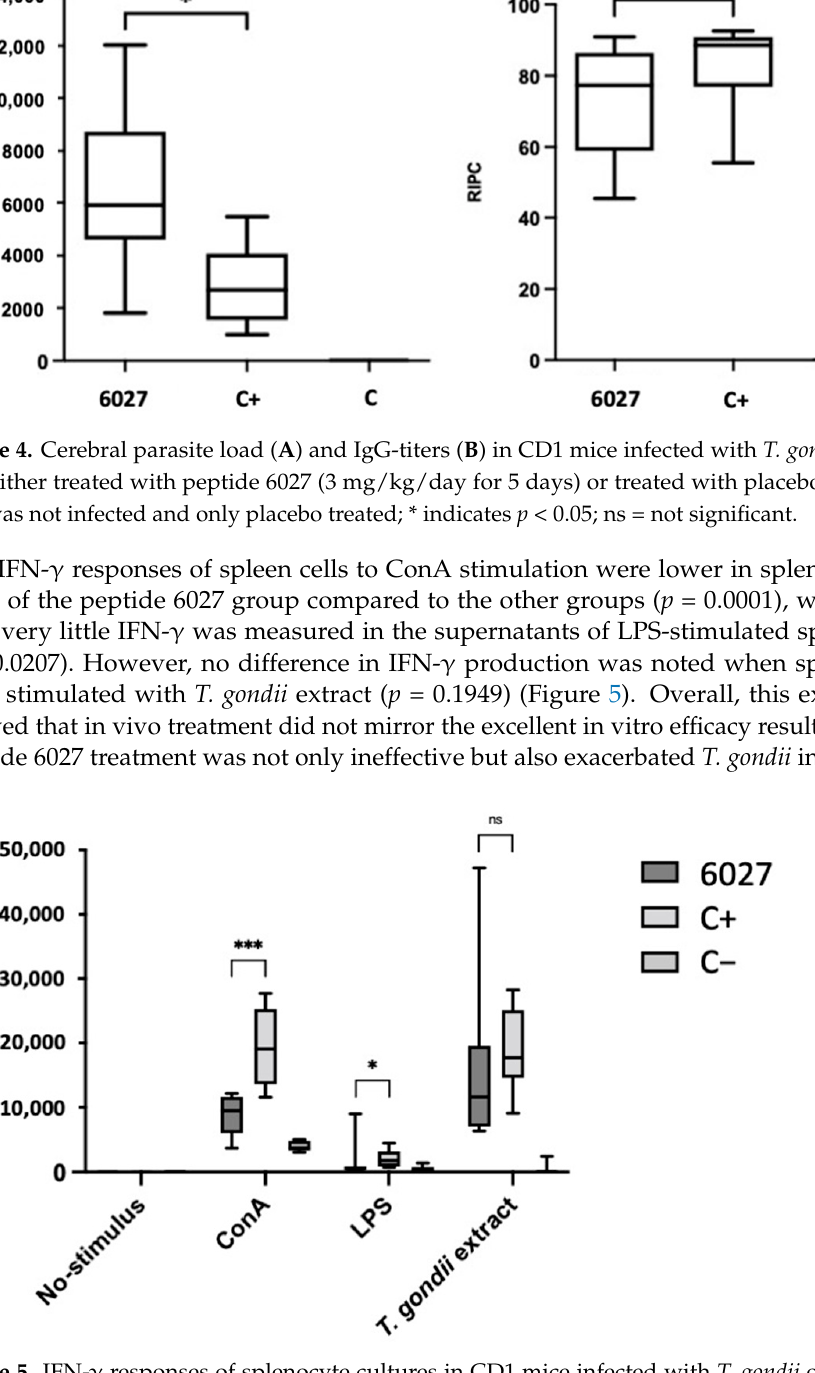
Figure 5. IFN- γ responses of splenocyte cultures in CD1 mice infected with T. gondii oocysts and either treated with peptide 6027 (3 mg/kg/day for 5 days) or treated with placebo only (C+). C − was not infected and only placebo treated; ns indicates no statistically significant difference; * = p < 0.05; *** indicates p = 0.0001; ns, not